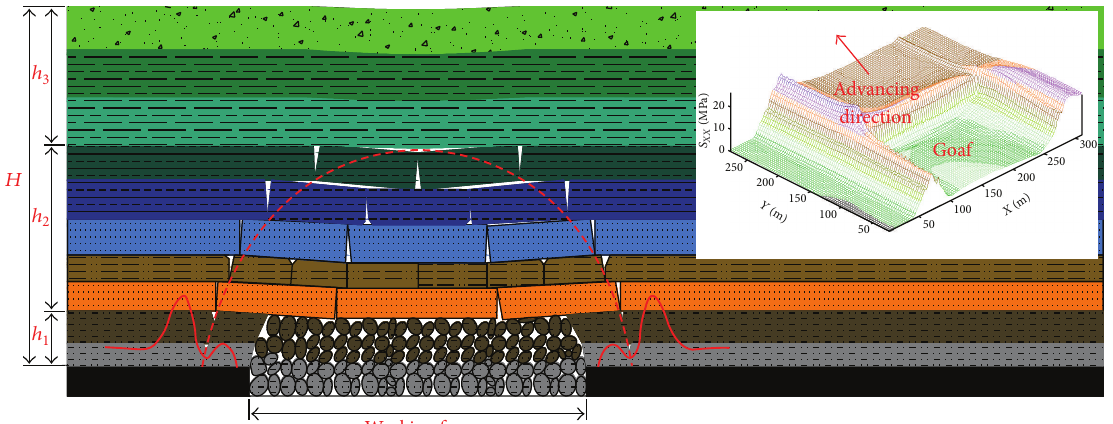
Figure 3: Structural model of the